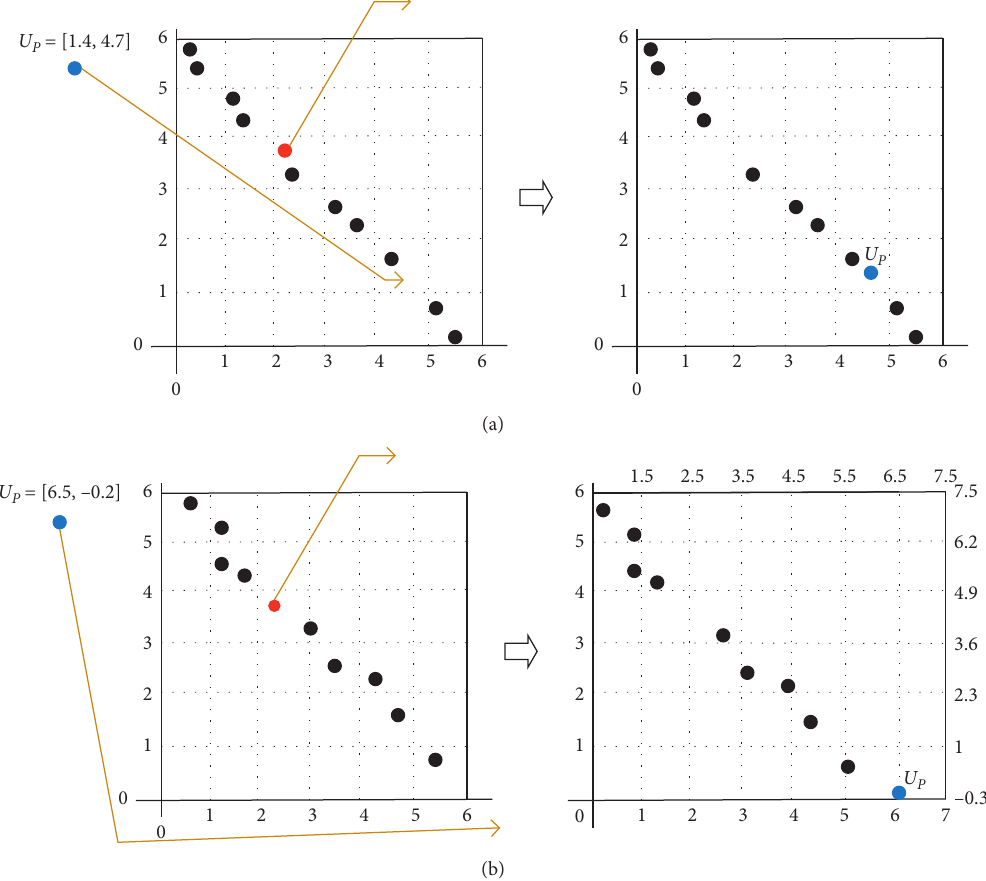
Figure 4: Illustration of adaptive grid idea. (a) The insertion of a new particle and (b) the insertion of a new particle outside the current